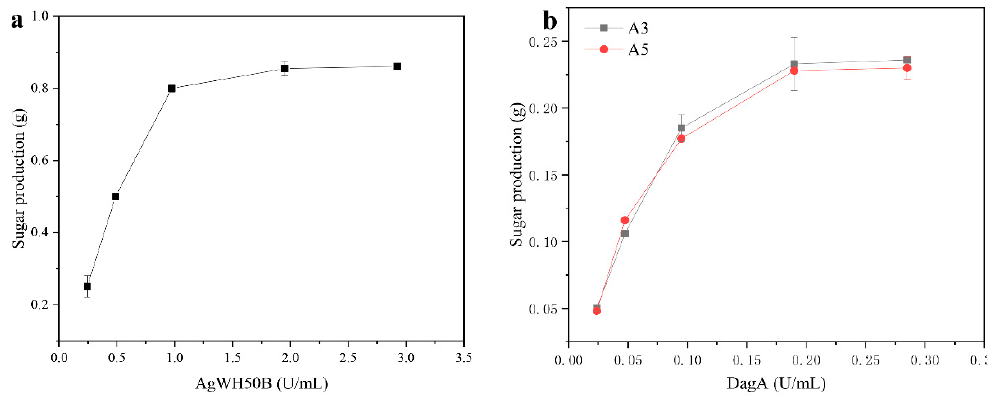
Figure 4. The optimization of enzyme amount for producing A3 ( a ) or both A3 and A5 ( b ). The value of each point was the mean of three experiments (n = 3). Error bars represent one standard deviation of triplicate measurements.